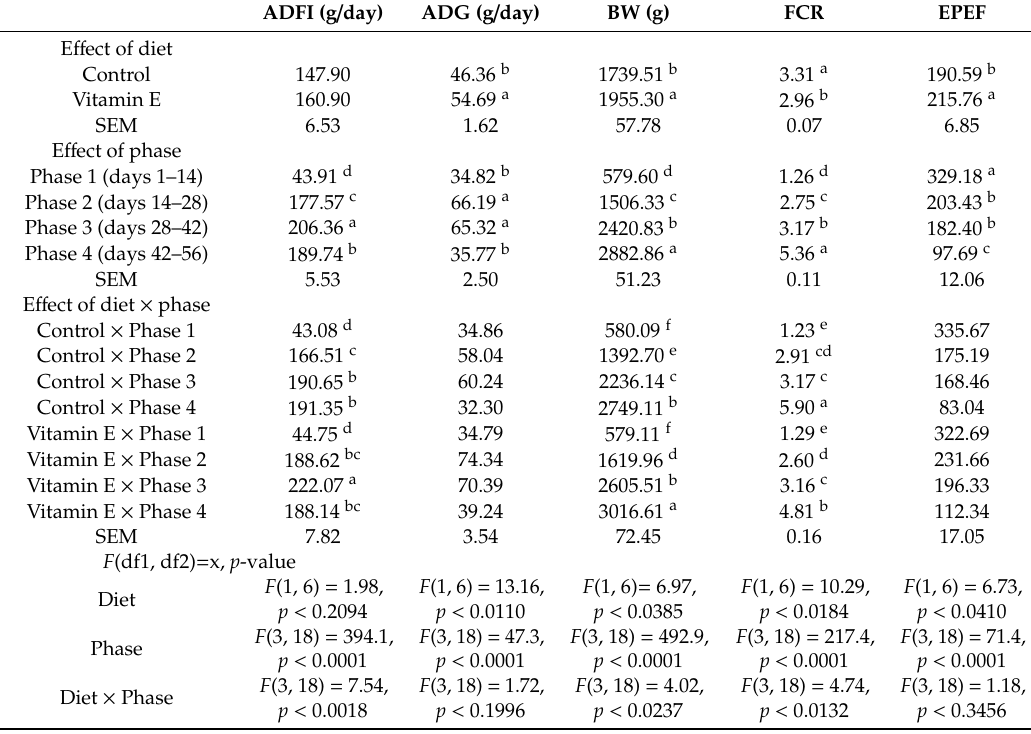
Table 2. Influence of dietary supplementation of vitamin E on the growth performance of 1- to 56-day-old male